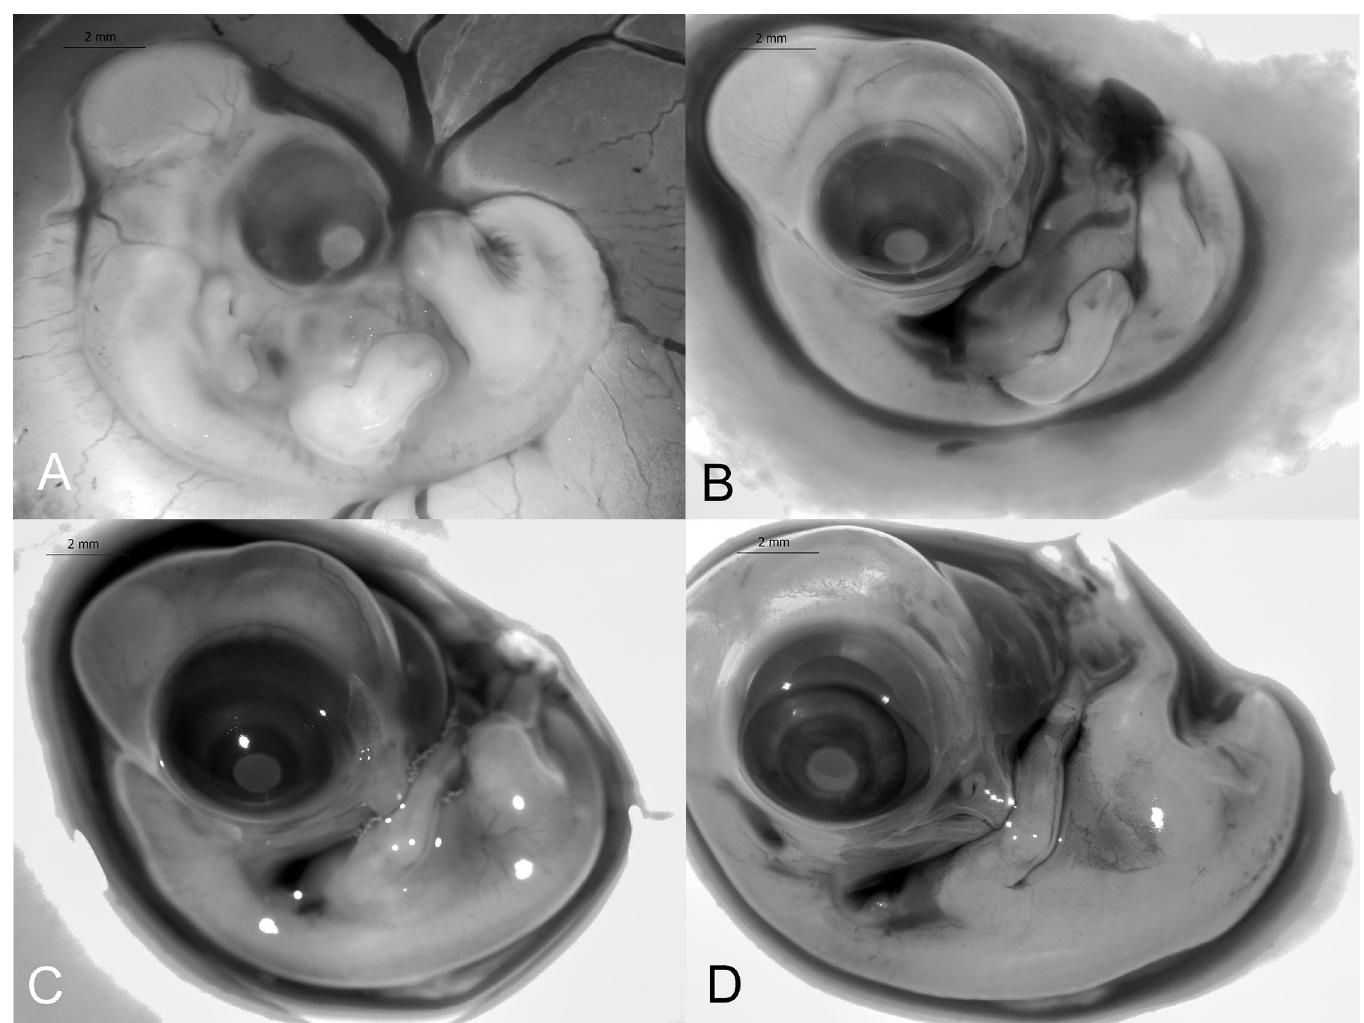
Fig 8. Stages 27–30 (6–11 d) of the California valley quail’s embryological stages of development. (A) Stage 27, digits are concave, and 4 toes are conspicuous. (B) Stage 28, wing tip and digital plate are more angular and webbing between digits is more concave. (C) Stage 29, elbow joint is more pronounced. (D) Stage 30, egg tooth is present.